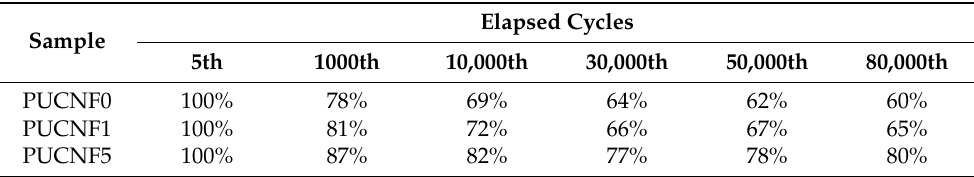
Table 3. Percentage reduction of the maximum compression load as a function of the elapsed cycles.